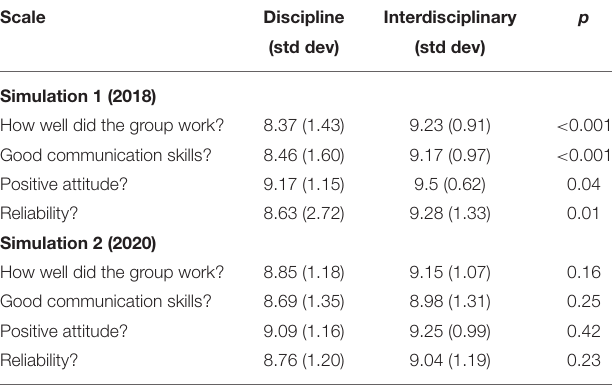
TABLE 3 | This table compares the self-reported experiences of students in their discipline and interdisciplinary groups for overall and specific positive group behaviors.